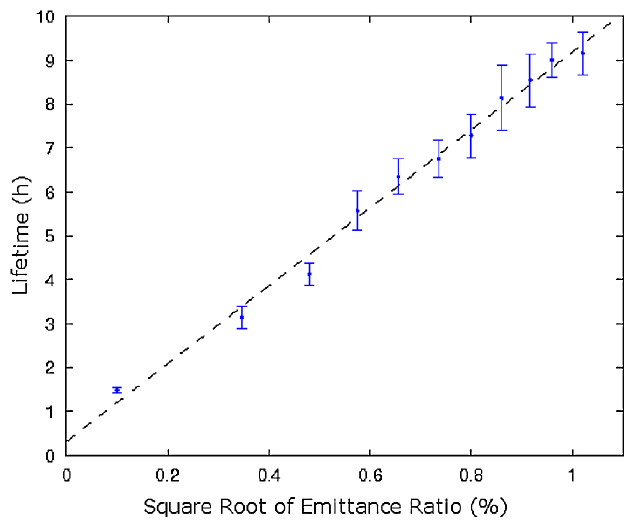
ffiffiffiffi p (cid:12) . Line of best fit